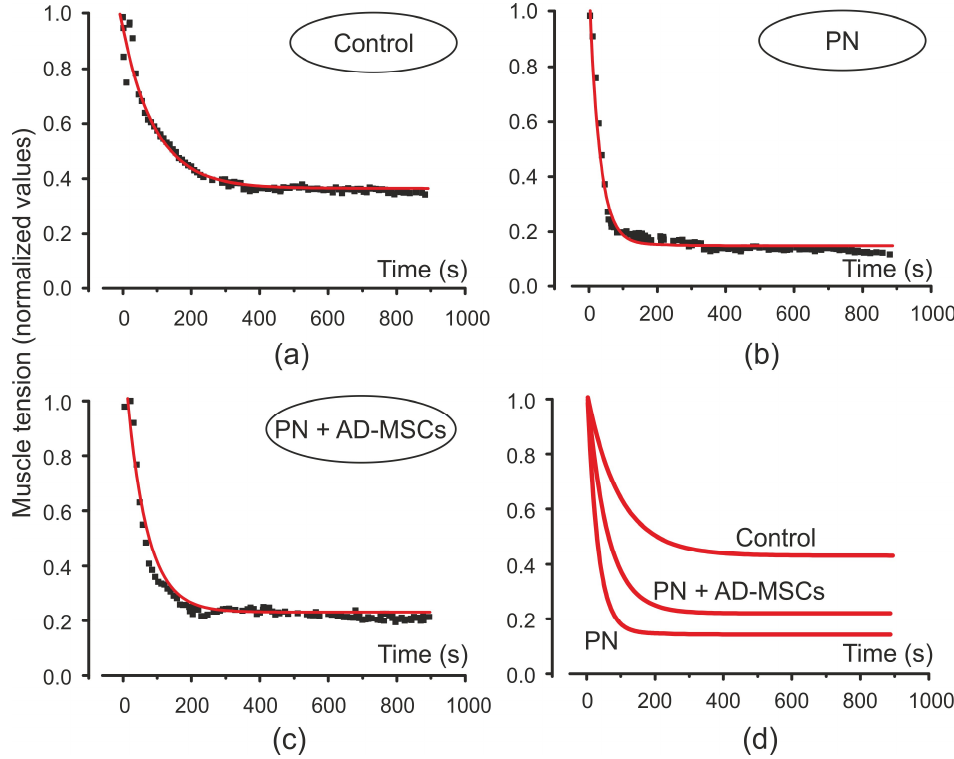
Figure 3. Amplitude values of the triceps surae muscle force induced by electrical stimulation at the beginning of single tetanic contractions (squares) and its exponential approximation (red curve) in control animals ( a ), mice with peripheral neuropathy (PN) ( b ) and treated animals with peripheral neuropathy (PN+AD-MSCs) ( c ). Exponential curves for all animals’ groups shown on ( d ).